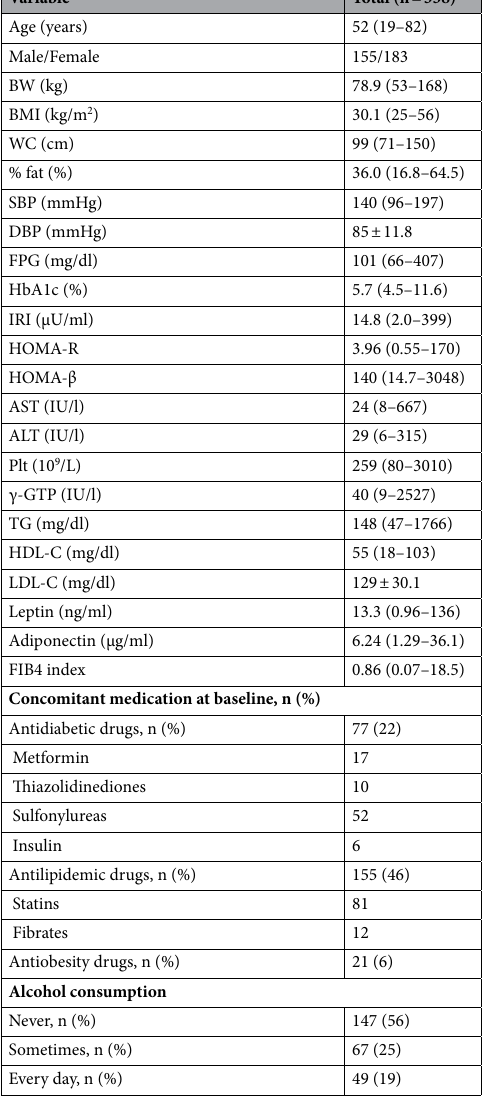
Table 1. Baseline characteristics of patients. Data are expressed as the mean ± SD, medians (min, max), or percentages. BW: body weight, BMI: body mass index, WC: waist circumference, SBP: systolic blood